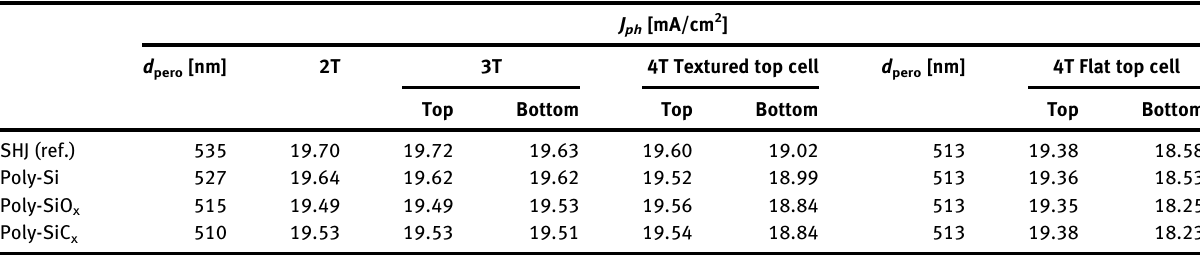
Tandem devices endowed with SHJ bottom cell are reported as reference. The  T architecture with textured top cell refers to Figure  (f) but with textured top cell as in Figure  (b); d pero stands for thickness of the perovskite absorber and in case of  T it is the thickness for which current matching is